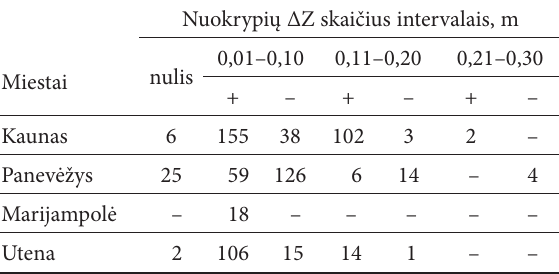
Table 6. Results of LIDAR point’s heights accuracy investigation according AGI control measurements Atspindintis paviršius